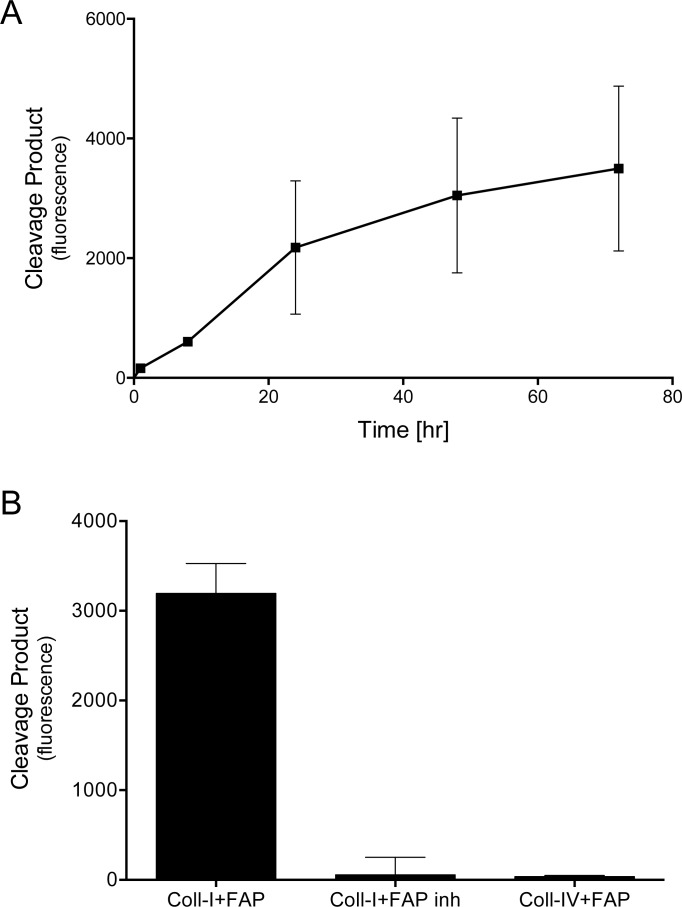
FAP selectively cleaves type I collagen.(A) DQ type I collagen was incubated with FAP (1 μg/ml) for increasing times and the extent of substrate cleavage quantified by measurement of increasing fluorescence. (B) DQ type I collagen was incubated with active or PMSF inhibited FAP (1 μg/ml) and DQ type IV collagen was incubated with active FAP at the same concentration for 24 hr. Degradation of DQ collagens was quantified by measurement increasing fluorescence. Shown are the means ± SD of at least 3 experiments.